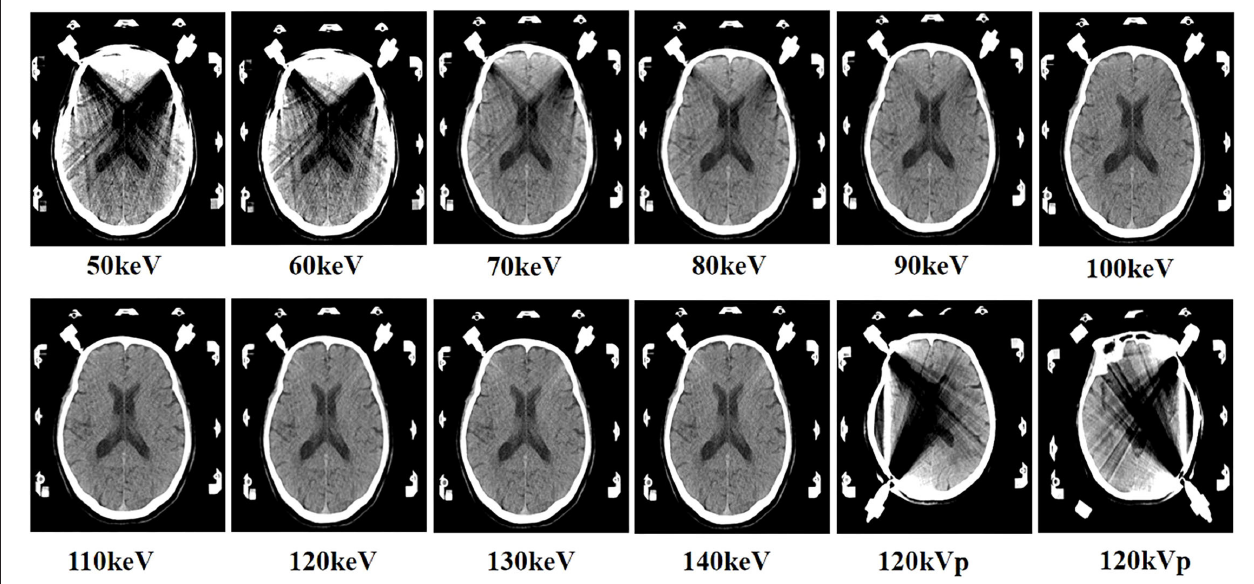
FIGURE 2 | The images of virtual monoenergetic images (VMI) and 120 kVp images. VMI of a 64-year-old male, from 50 keV to 140 keV. Approximately, 50–80 keV VMI displayed beam-hardening artifacts at the long-axis direction of nails. Approximately, 90–140 keV VMI showed that the artifacts became reduced gradually with the increase of keV and the brain structures near the nail became more visible. The 120 kVp images that displayed obviously beam-hardening artifacts at the level of stereotactic nails.